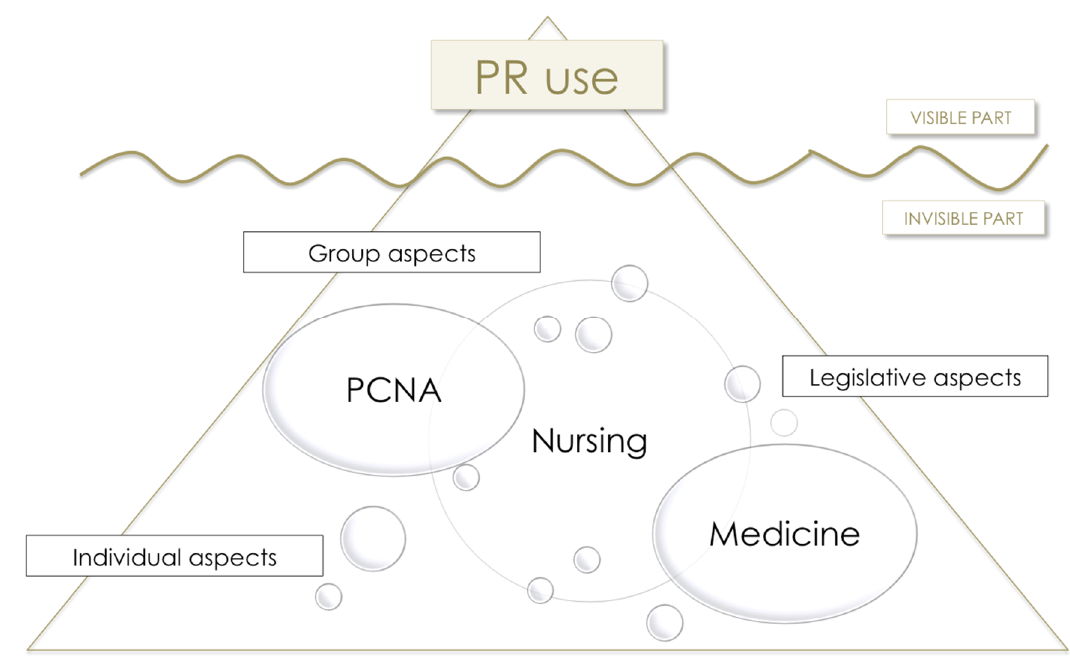
Figure 1. Explanatory model of PR use, “Iceberg Theory”. Abbreviations: PCNA: patient care nursing assistants; PR: physical re- straints.